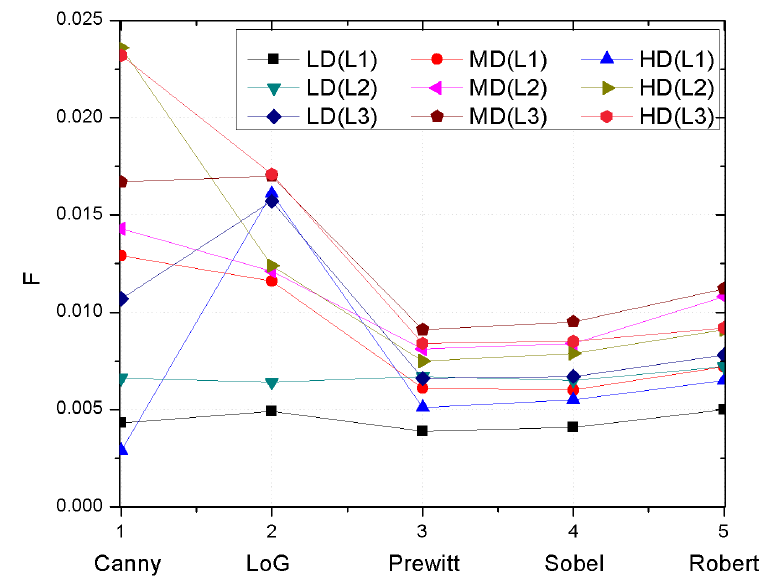
Fig. 13. F-measure values for the Haar wavelet